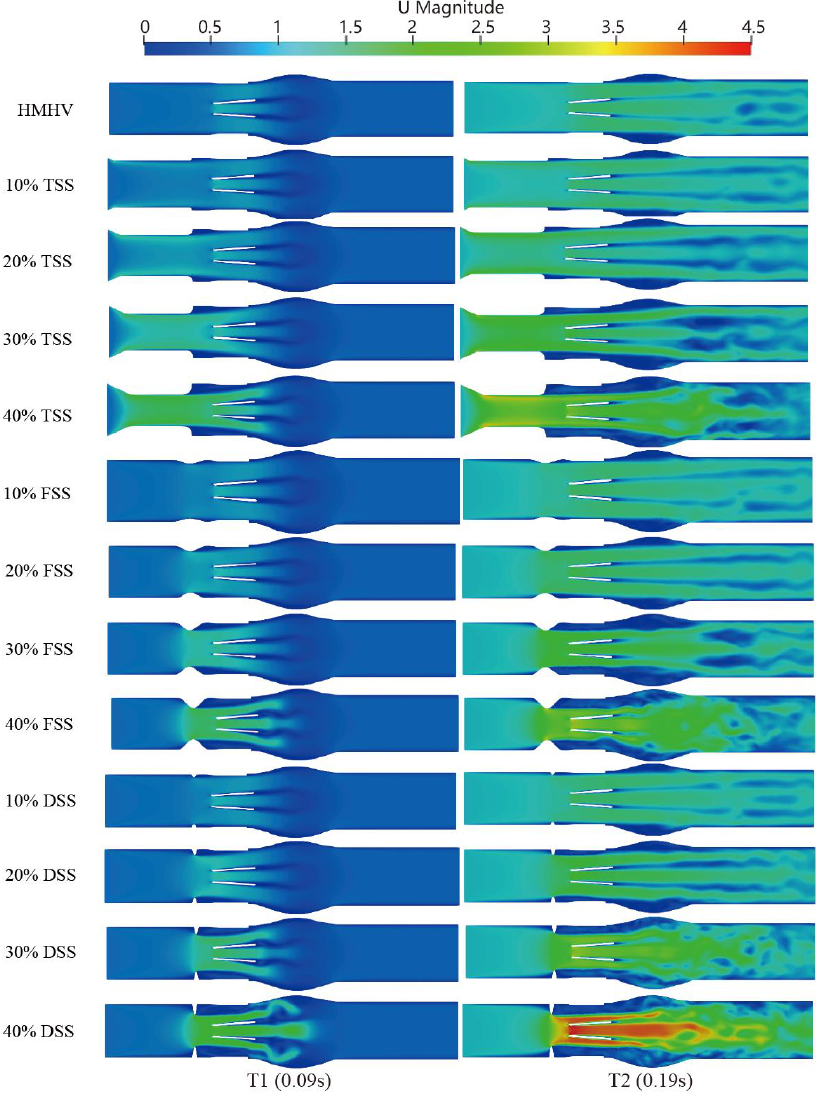
Figure 7. Velocity contours at SAS1, SAS2, and SAS3 in different percentage blockage (10%, 20%, 30%, and 40%) at T1 (peak) and T2 (deceleration phase).